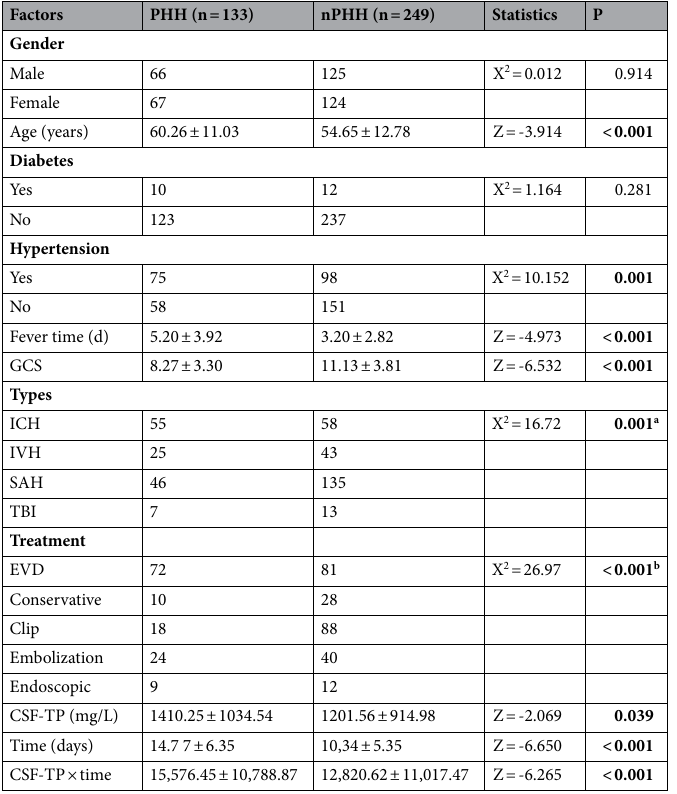
Table 1. Clinical characteristics of patients in the derivation cohort and univariate analysis of association between potential risk factors and PHH. PHH post-hemorrhagic hydrocephalus, nPHH not post-hemorrhagic